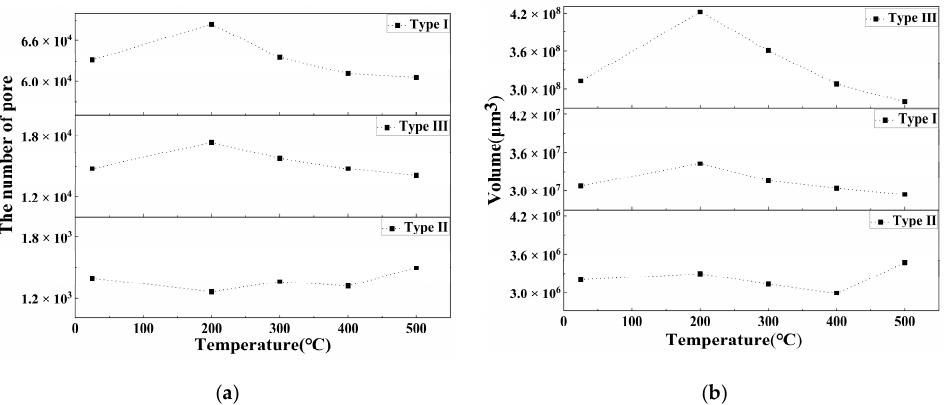
Figure 4. ( a ) The amount and ( b ) volume change of three kinds of pores in the range of 25–500 °C.